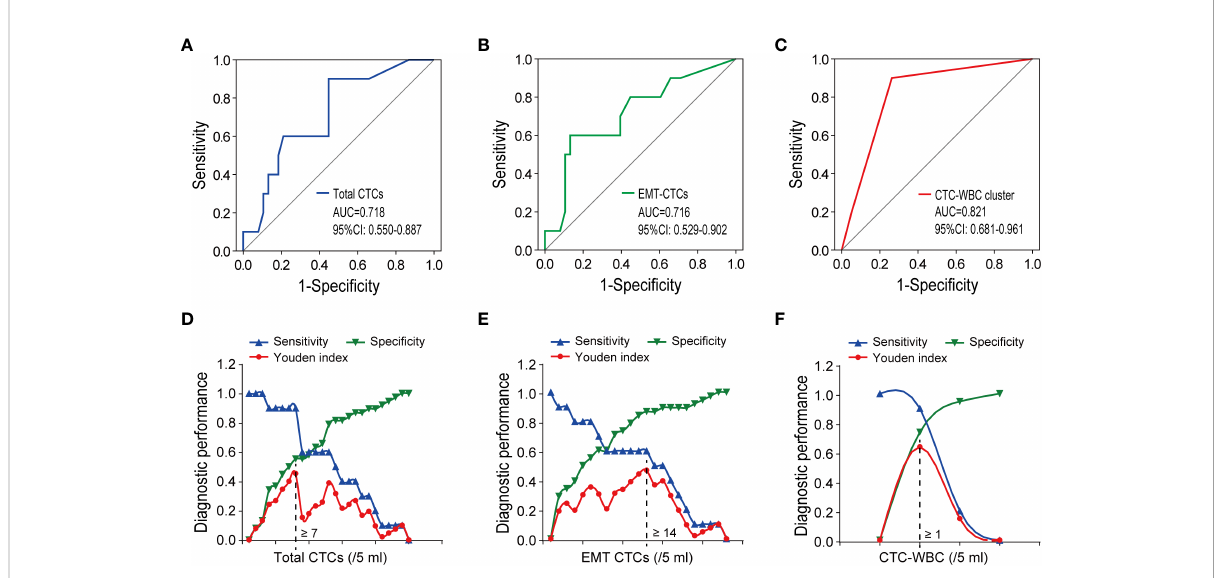
FIGURE 3 The performance of CTCs parameters (total CTCs, EMT-CTCs, and CTC-WBC cluster) in discriminating the extrahepatic metastatic HCC patients from the non-metastatic patients. (A – C) Simulative ROC curves of the CTCs parameters for the diagnosis of HCC extrahepatic metastasis. (D – F) Diagnostic performance (sensitivity, speci fi city, and Youden index) in the discrimination of HCC extrahepatic